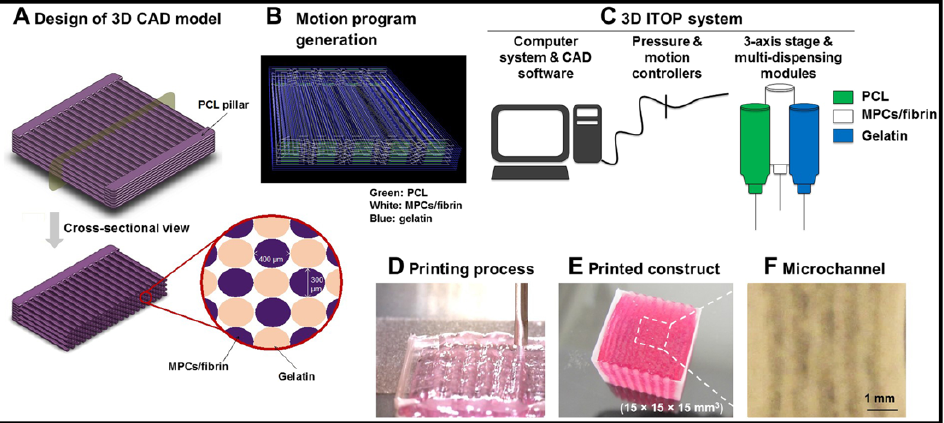
Figure 7. 3D bioprinted human skeletal muscle construct for muscle function restoration [136]. Reprinted by permission of springer Nature. Copyright © 2018 by Springer Nature.